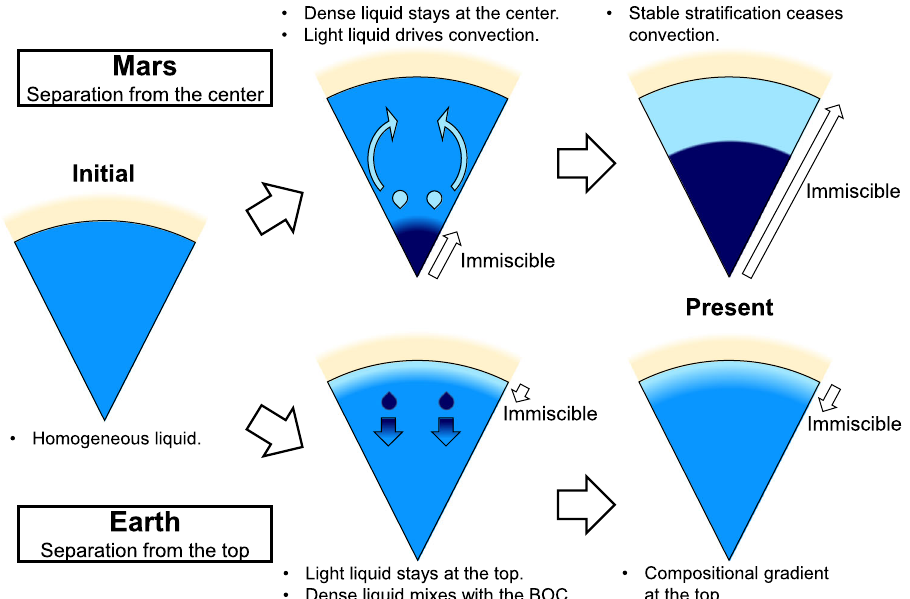
Fig. 3 Strati fi cation in Mars ’ and Earth ’ s cores caused by liquid immiscibility. Light- and dark-blue represent buoyant and dense liquids, respectively. In the Martian core, liquid immiscibility that started from the center had driven convection and dynamo but eventually formed entire core strati fi cation which ended Mars ’ planetary magnetic fi eld. In the case of the Earth, on the other hand, the core liquid immiscibility commenced from the top, leading to strati fi cation at the uppermost core which is now observed as E ′ layer. These illustrations are not to